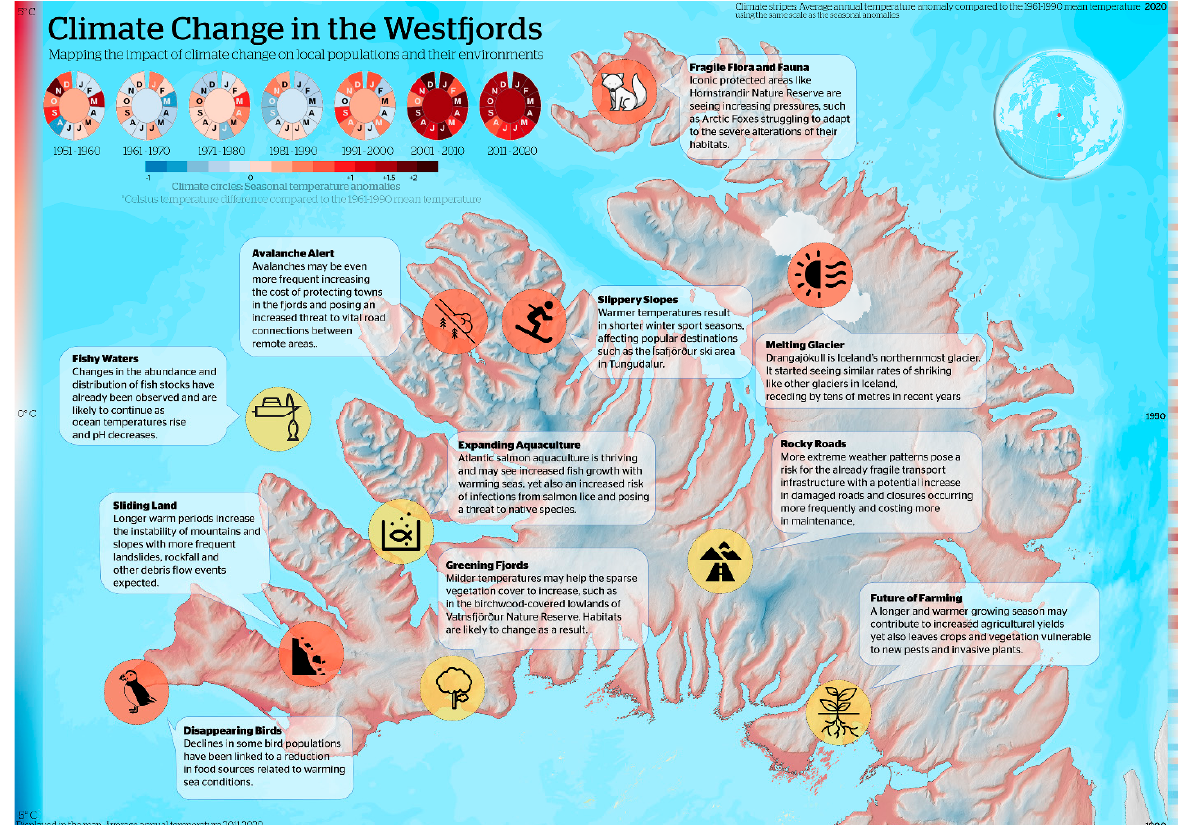
Figure 11. Potential local impacts due to climate change in the Westfjords region.